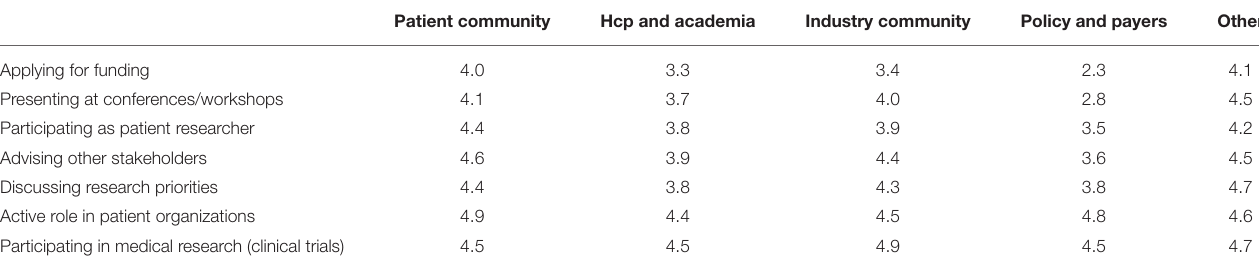
TABLE 2 | Patient involvement rated per